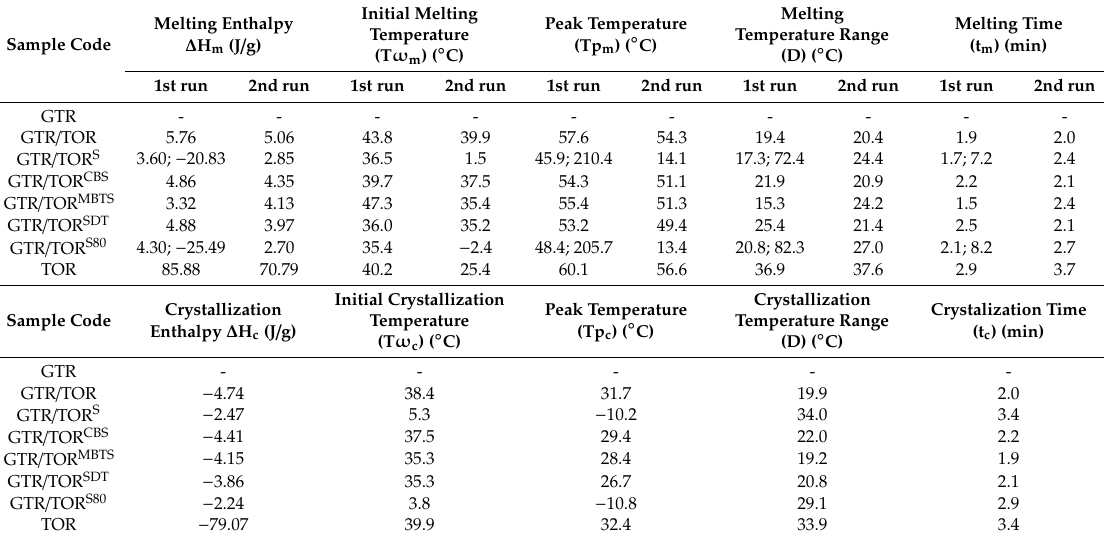
Table 9. Results of the thermal transitions of the samples studied by